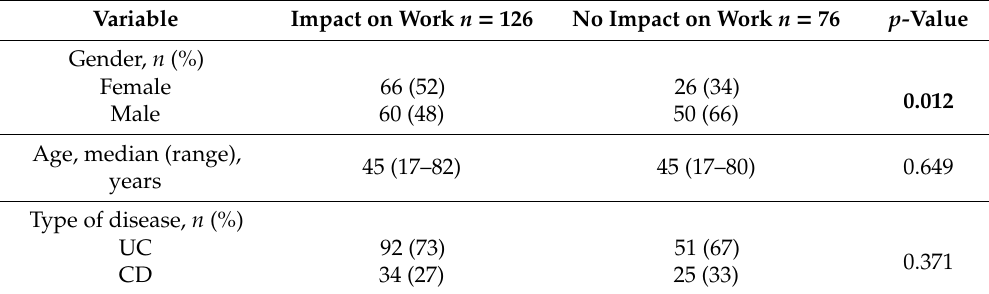
Table 3. Impact of IBD on working activities in the 202 patients with inactive disease. Variable Impact on Work n = 126 No Impact on Work n = 76 p- Value